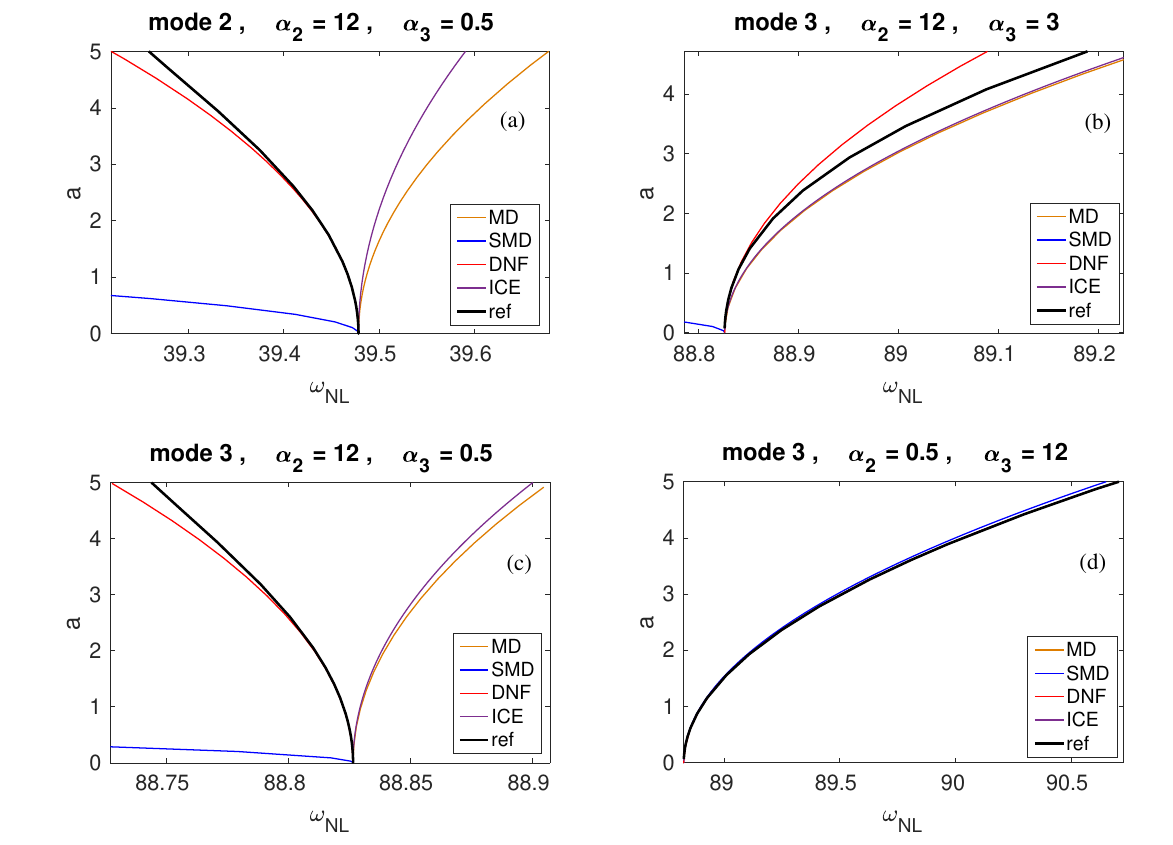
Figure 2. Backbone curves for the linear beam on a nonlinear elastic foundation. ( a ) Second mode, α 2 = 12, α 3 = 0.5, ( b ) third mode, α 2 = 12, α 3 = 3, ( c ) third mode, α 2 = 12, α 3 = 0.5. ( d ) third mode, α 2 = 0.5, α 3 = 12. Reference solution (thick black line): continuation on a solution built from the 10 linear modes